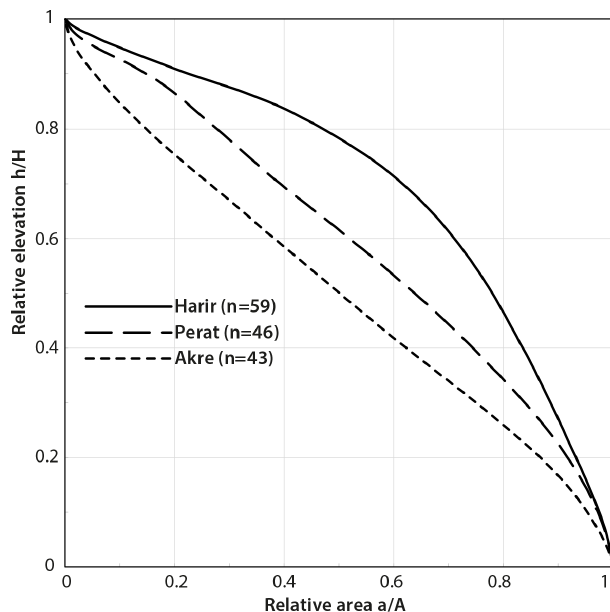
Figure 6. Present-day hypsometric curves of the studied anticlines. The curves are calculated as a total weighted mean for drainage basins within each anticline. We only use those parts where Upper Cretaceous carbonate rocks crop out and we exclude wind gaps, water gaps, and the plunging tips of anticlines. n is the number of basins used in the calculation of the hypsometric curve for each